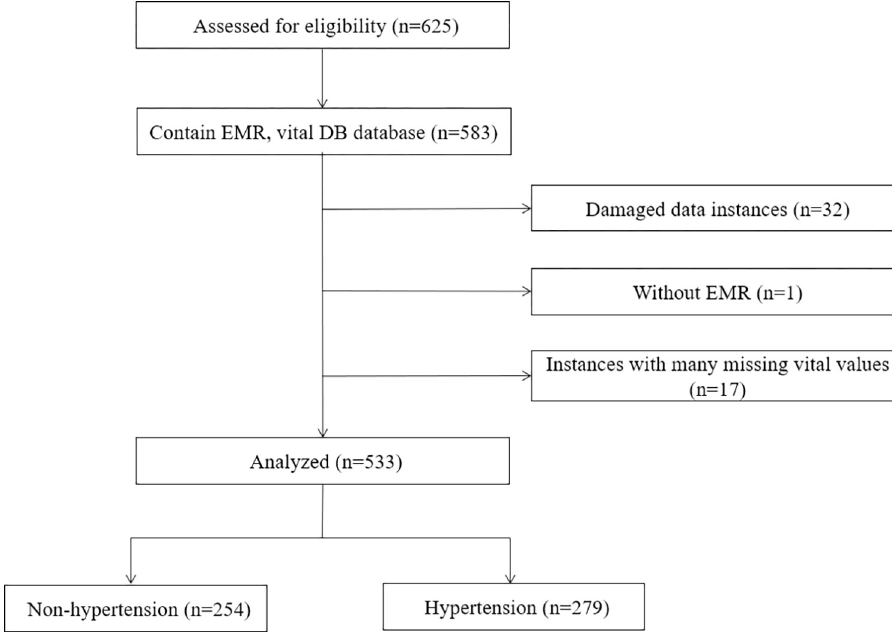
Fig 1. Flow diagram outlining data filtering